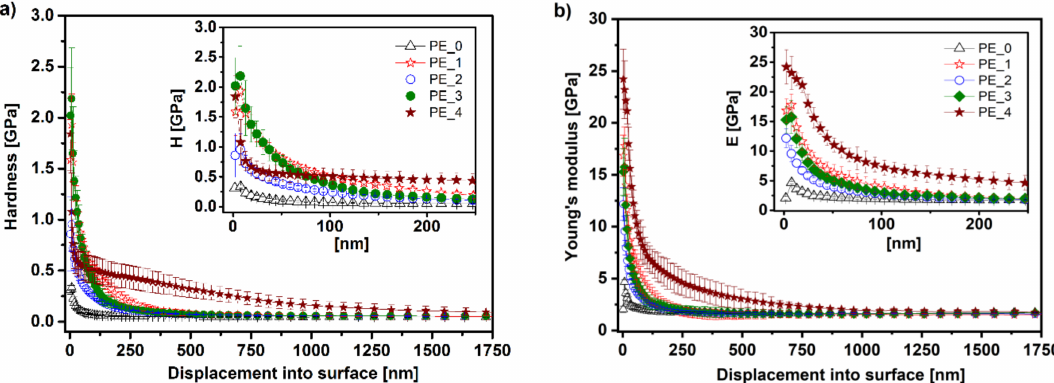
Figure 6. ( a ) Hardness and ( b ) Young’s modulus profiles of tested samples.